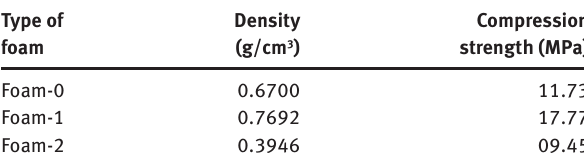
Table 2: Density and compressive strength of the